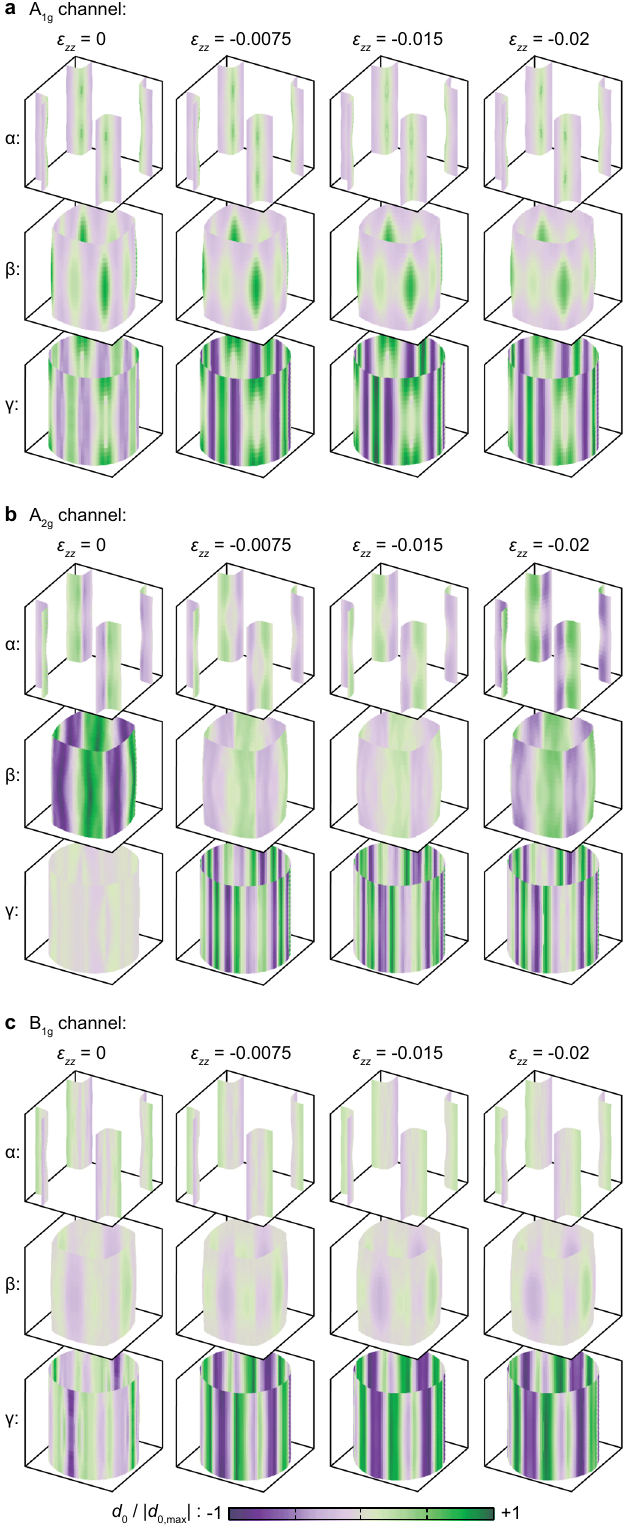
Fig. 8 | Additionalgap structures. Gap structures at J / U =0.15for,from ( a – c ),the A 1 g , A 2 g ,and B 1 g channels,attheindicatedstrains.Foreachchannel,thetop,middle, and bottom rows show the gap on the α , β , and γ sheets,